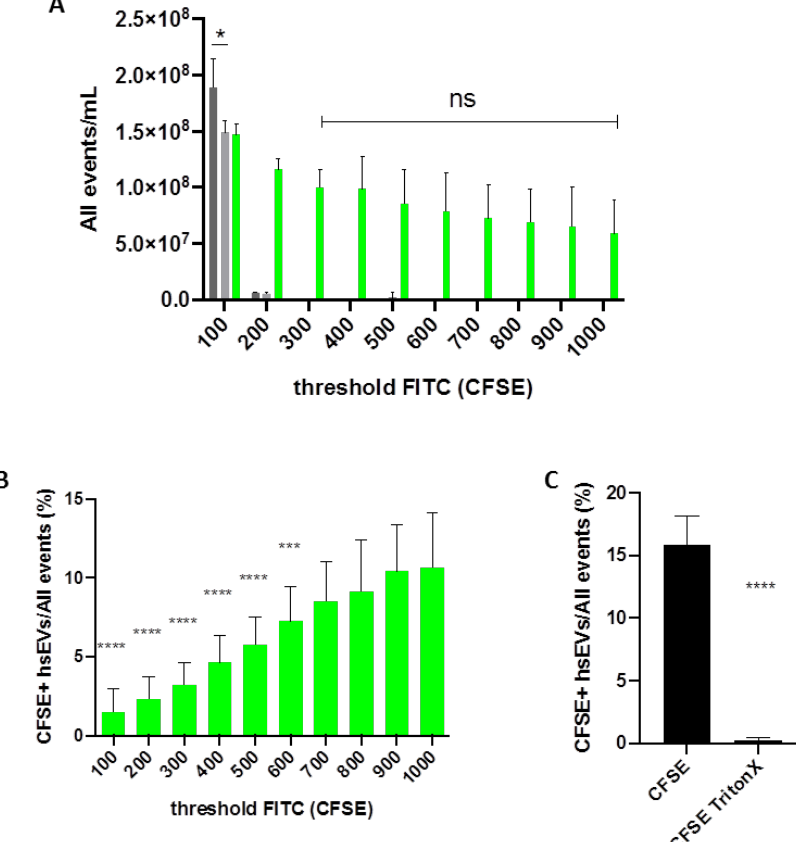
Figure 4. Impact of cytometer settings on the detection of hsEVs. ( A ) Shown is the total amount of events detected by the flow cytometer in the FITC channel and expressed as all events/mL. Bar graph shows mean ± SD ( n = 4) for different threshold settings (100–1000). PBS control (dark grey), unlabeled hsEVs (light grey), CFSE-labeled hsEVs (green). For the comparison of PBS and unlabeled hsEVs, student’s t -test (two-tailed) was used. Statistical analysis of CFSE-labeled hsEVs (300–1000) was done using two-way ANOVA and Tukey’s multiple comparison test. p values < 0.05 were considered statistically significant. ( B ) Comparison of the relative amount of CFSE + hsEVs within all events. Bar graph shows mean ± SD ( n = 4) for different threshold settings (100–1000). Statistical analysis of CFSE-labeled hsEVs (threshold 100–1000) was done using two-way ANOVA and Tukey’s multiple comparison test. p values < 0.05 were considered statistically significant. Shown are the results of the multiple comparisons of 1000 to all the other values only. ( C ) HsEVs were CFSE-labeled and incubated with or without the detergent Triton X-100 (0.1%). Bar graph shows the impact of detergent treatment on the quantification of intact hsEVs. Samples were measured with a threshold of 1000 for the FITC channel representing the setting for the highest detection sensitivity. Statistical analysis was done using student’s t -test (two-tailed). p values < 0.05 were considered statistically significant. * p < 0.05, *** p < 0.01, **** p < 0.001, ns = not significant.